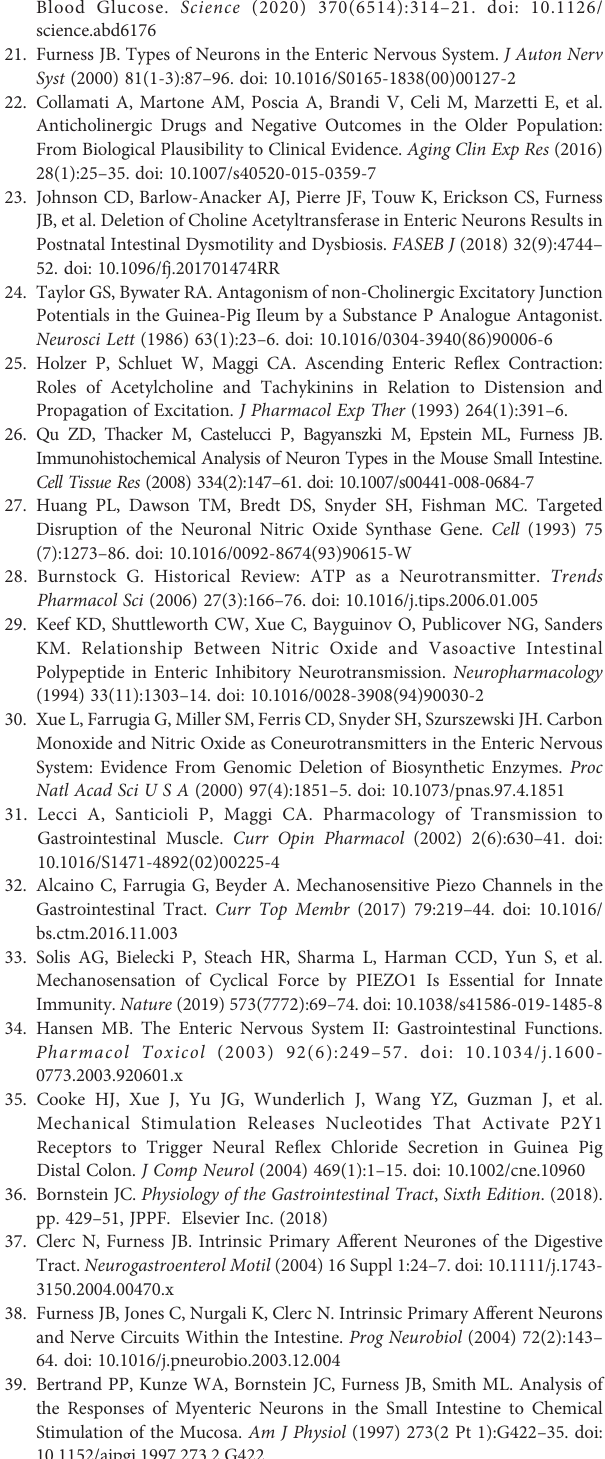
Supplementary Figure 1 | Expression of chemokine receptors, C-type leptin receptors and other genes of interest in different ENS subsets. Dotplots showing the percentage of expressing cells as well as average expression within the indicated identi fi ed neuronal clusters for selected murine chemokine receptor, C-type leptin